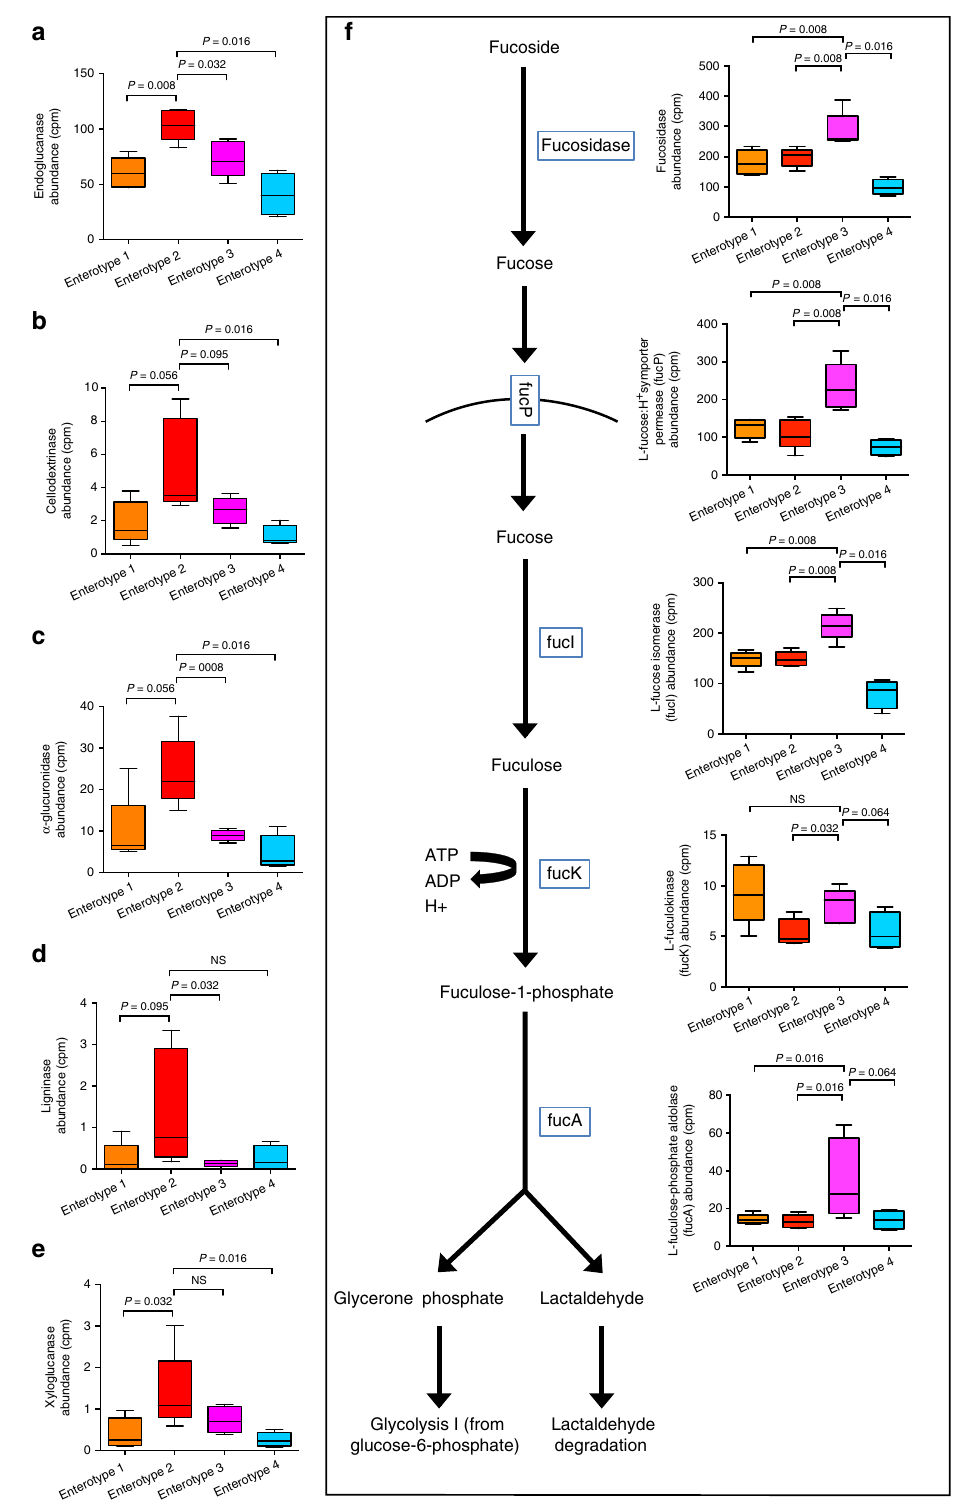
Fig. 8 Genes coding for plant fi ber degrading enzymes are enriched in the Treponema -abundant, LF-associated WLG enterotype 2, while genes encoding enzymes involved in fucose degradation are elevated in the Prevotella -abundant enterotype 3. Box-and-whiskers plots showing the relative abundance (in counts per million sequences, cpm) of a endoglucanase, b cellodextrinase, c alpha-glucuronidase, d ligninase, and e xyloglucanase (identi fi ed by HUMAnN2 analysis) in WLG enterotypes 1 ( n = 5), 2 ( n = 5), 3 ( n = 5) and 4 ( n = 4). f Schematic of the pathway for fucose degradation, along with box- and-whiskers plots showing the relative abundance (in counts per million sequences, cpm) of genes (identi fi ed by HUMAnN2 analysis) encoding the enzymes or transporter in samples from WLG enterotypes 1 ( n = 5), 2 ( n = 5), 3 ( n = 5) and 4 ( n = 4). Two-tailed P- values from Mann – Whitney tests are indicated. NS not signi fi cant at α =